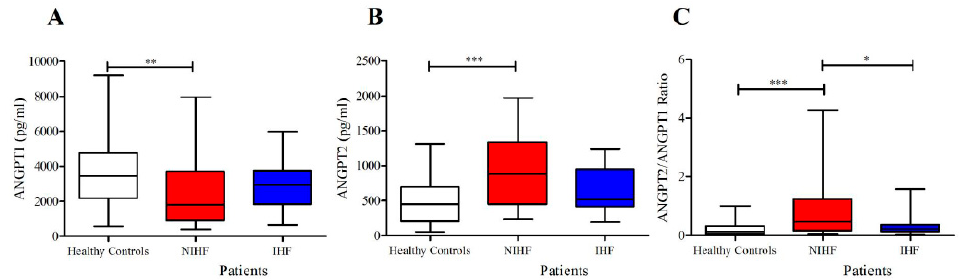
Figure 4. ( A ) Plasma concentrations of angiopoietin-1 (ANGPT1) in ischemic (IHF) and non-ischemic (NIHF) patients, and in healthy controls; ( B ) plasma concentrations of ANGPT2 in IHF and NIHF patients, and in healthy controls; ( C ) ANGPT2 / ANGPT1 ratio in IHF and NIHF patients, and in healthy controls. Data are shown as the median (horizontal block line), the 25th and 75th percentiles (boxes), and the 5th and 95th percentiles (whiskers) (statistical analysis was performed by one-way ANOVA and Bonferroni’s multiple comparison test). * p < 0.05; ** p < 0.01; *** p < 0.001.